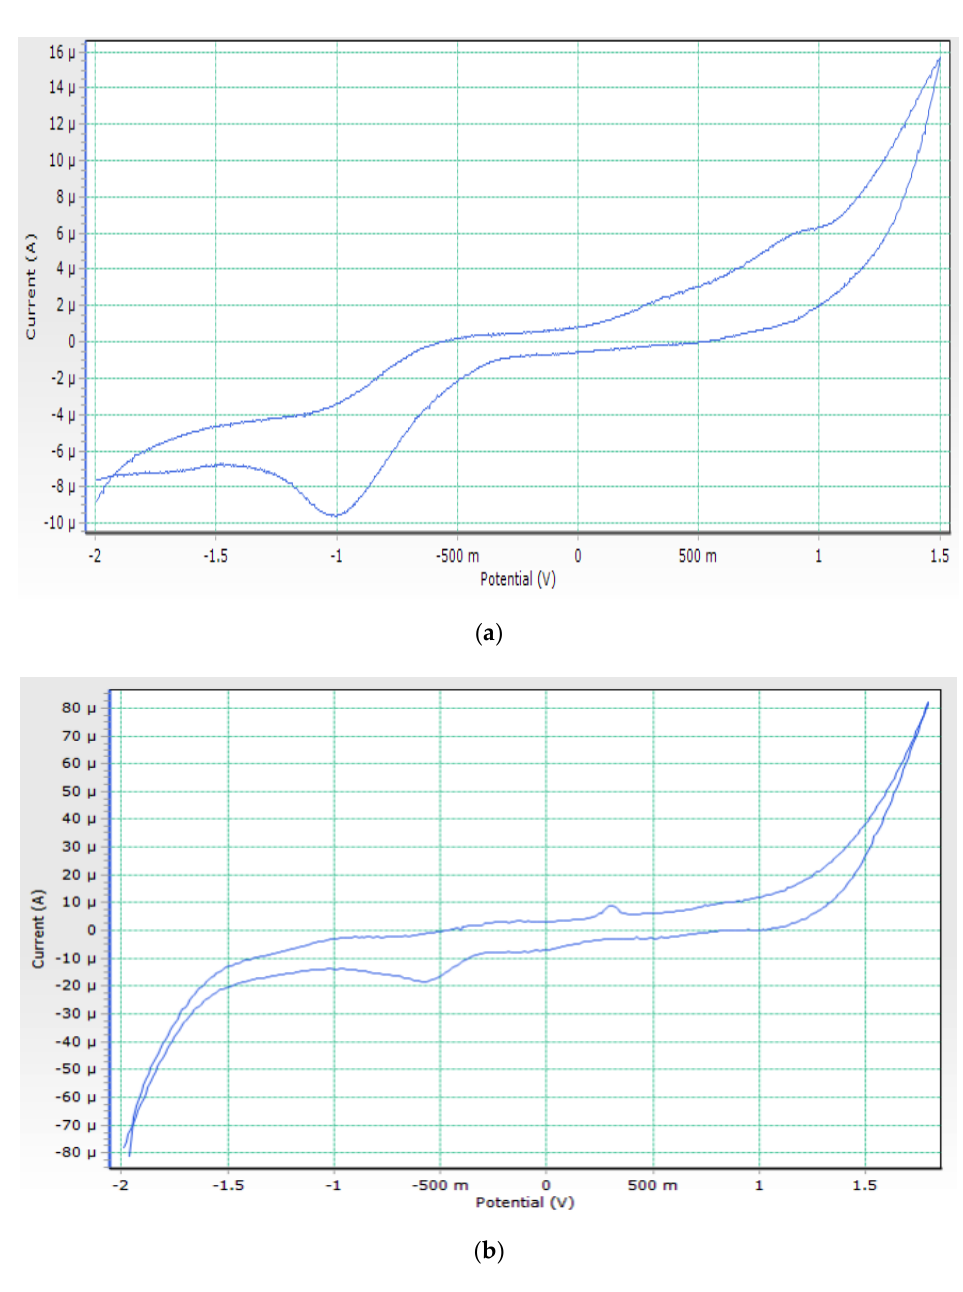
Figure 2. ( a ). Cyclic voltammogram of Co(II) complex. ( b ). Cyclic voltammogram of Ni(II) complex.